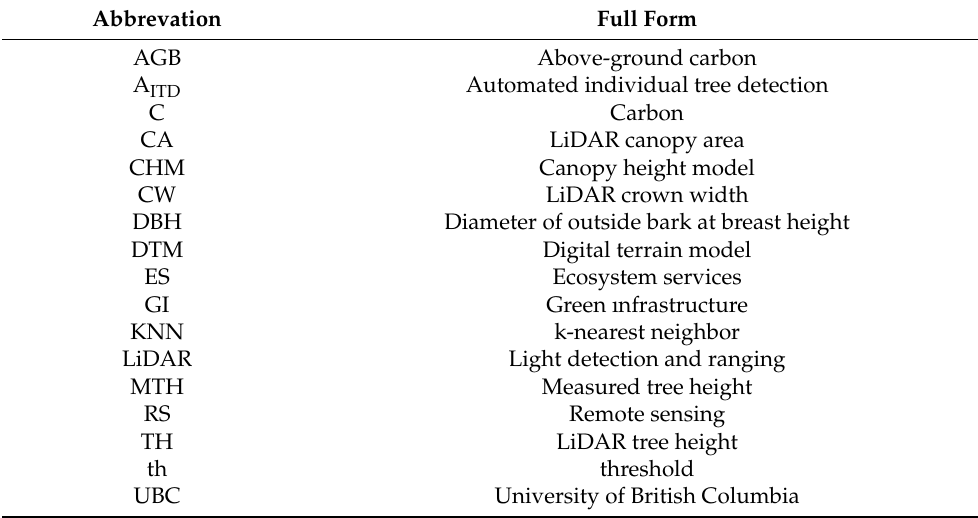
Table A1. List of abbreviations used in the manuscript along with their full